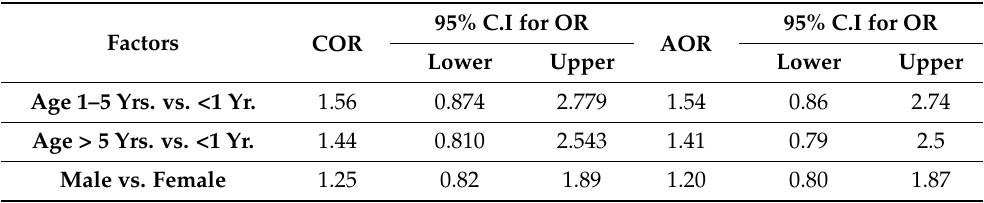
95% C.I for OR 95% C.I for OR AOR Lower Upper Lower Upper